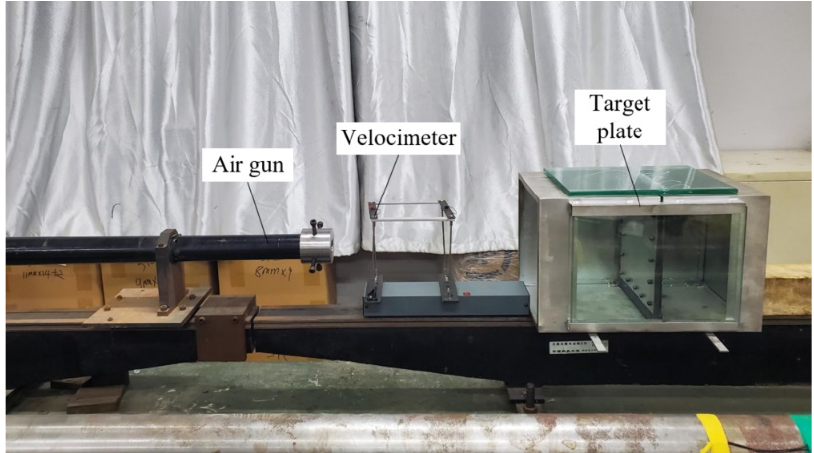
Figure 4. Impact experiment equipment.